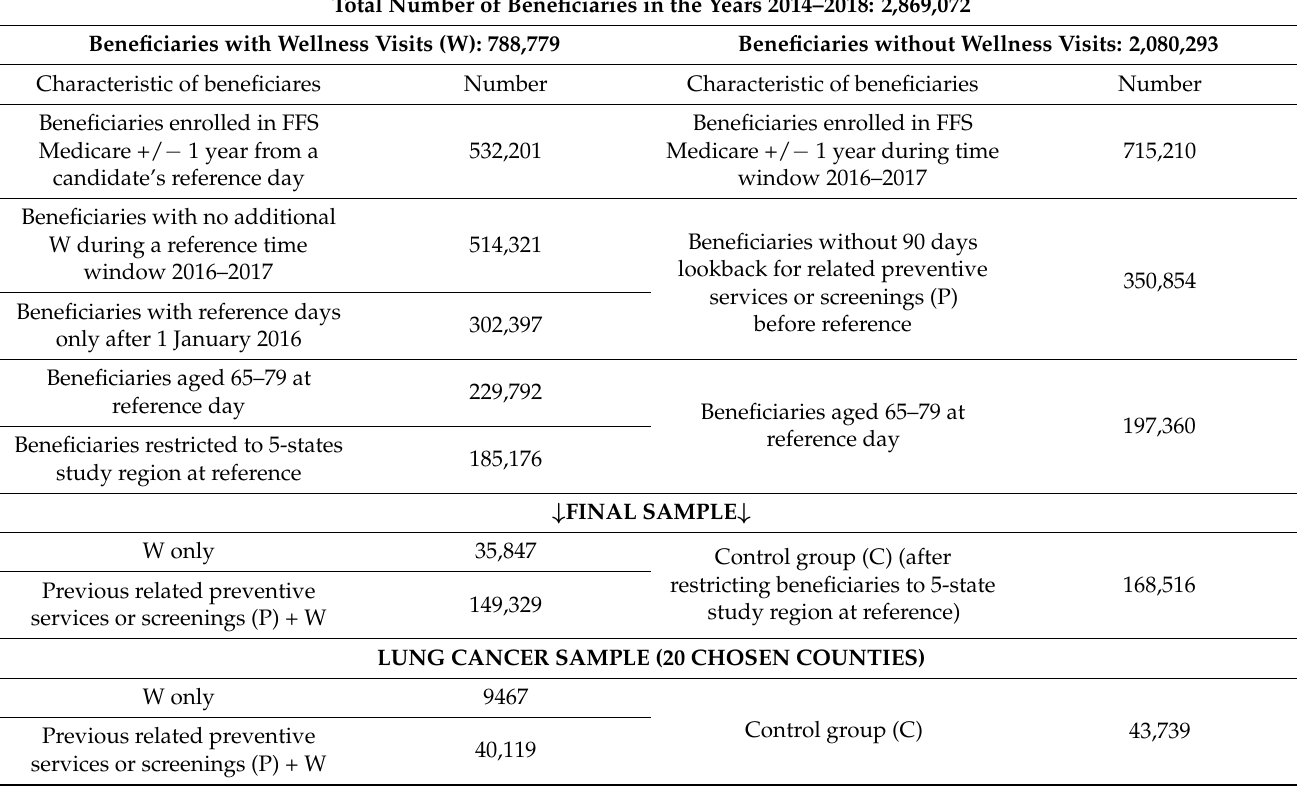
Table 1. Primary cohort and extracted sample